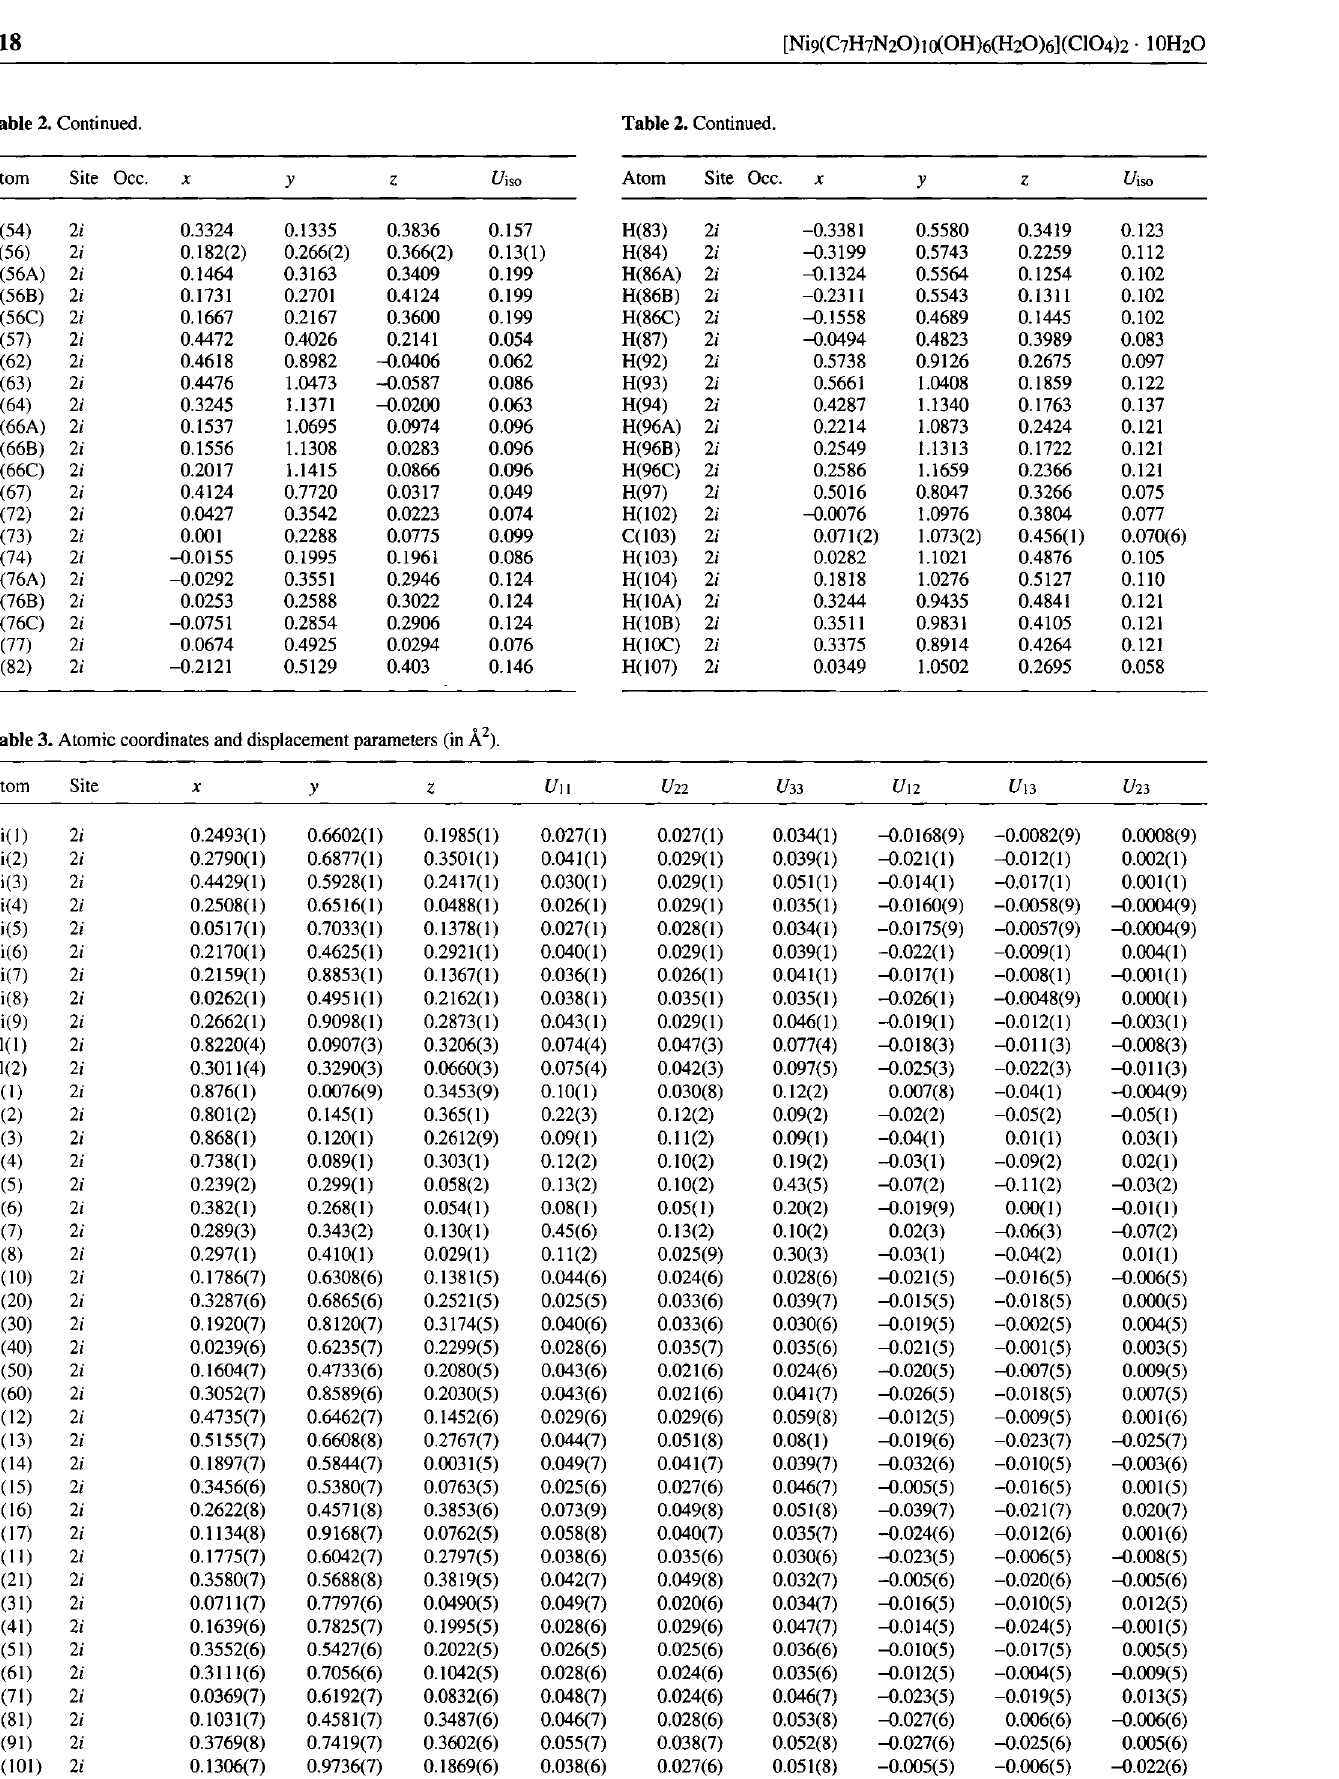
Table 3. Atomic coordinates and displacement parameters (in Ä 2